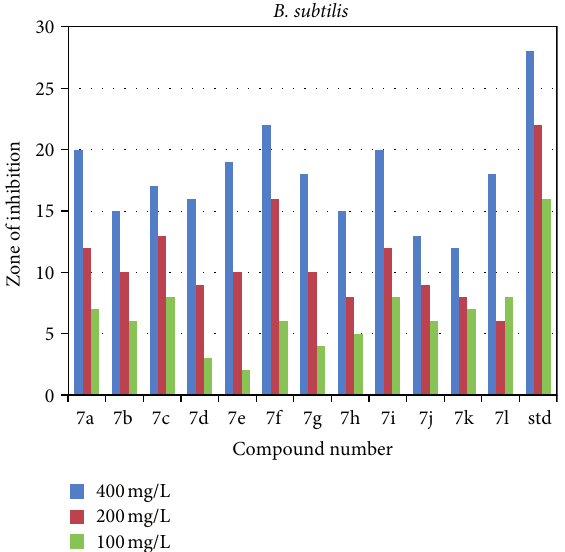
F 1: Antibacterial activity against B. subtilis .